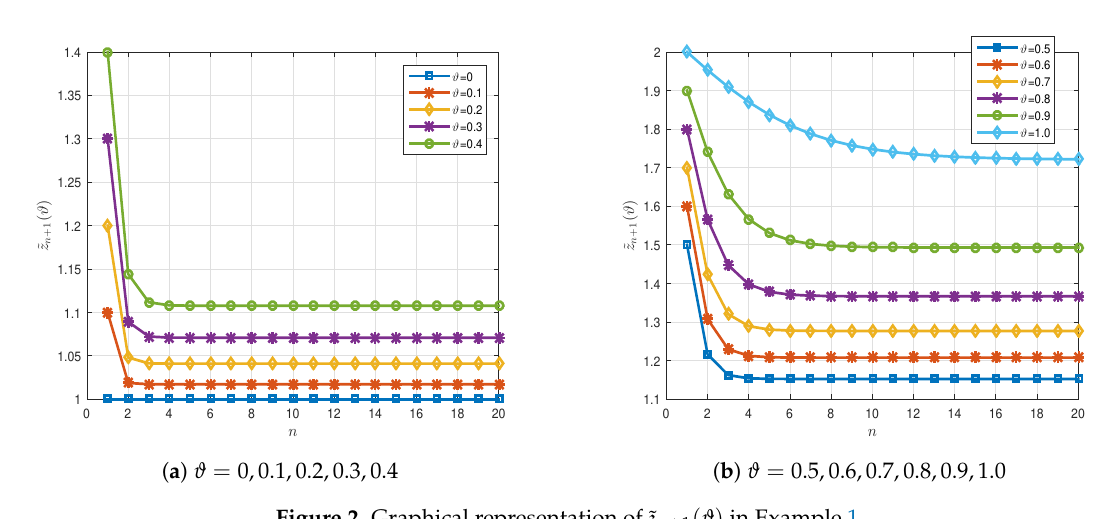
Figure 2. Graphical representation of ˜ z n + 1 ( ϑ ) in Example 1. Table 4. Numerical results of ˜ z n + 1 ( ϑ ) for n = 1,2, . . . ,20 and ϑ = 0.5, 0.6, 0.7, 0.8, 0.9, 1 by using